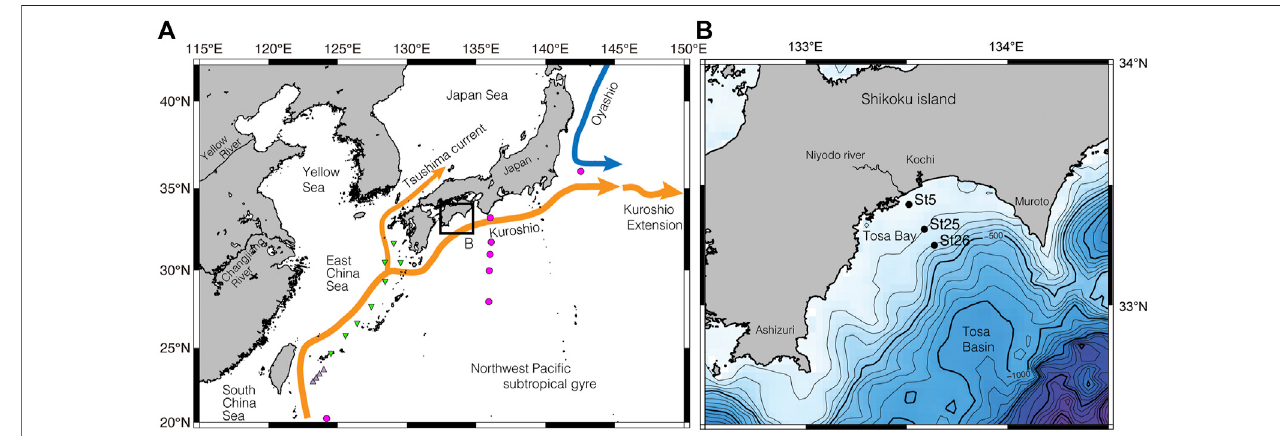
FIGURE 1 | Site location maps. (A) Index map with major surface currents in the northwest Paci fi c and marginal seas. The red circles indicate the location of the isotopedatain Horibeand Ogura(1968), andlightpurple triangles showthelocation oftheisotopedataat Kuroshiosites inHorikawaet al.(2015).Greentrianglesshow sameatOkinawaTroughsitesinHorikawaetal.(2015). (B) Bathymetricmapshowingsitelocationsofsurfacesedimentandseawatersamplesonthecontinentalshelfin Tosa Bay; map location shown in (A) . Contour interval, 100 m.